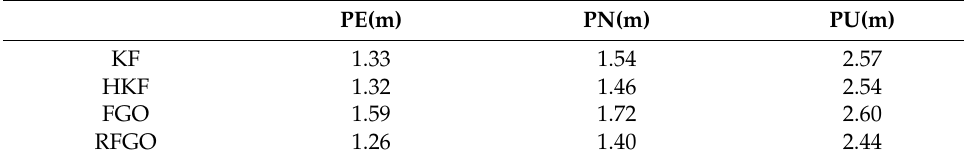
Table 3. Comparison of the positioning error in the test.